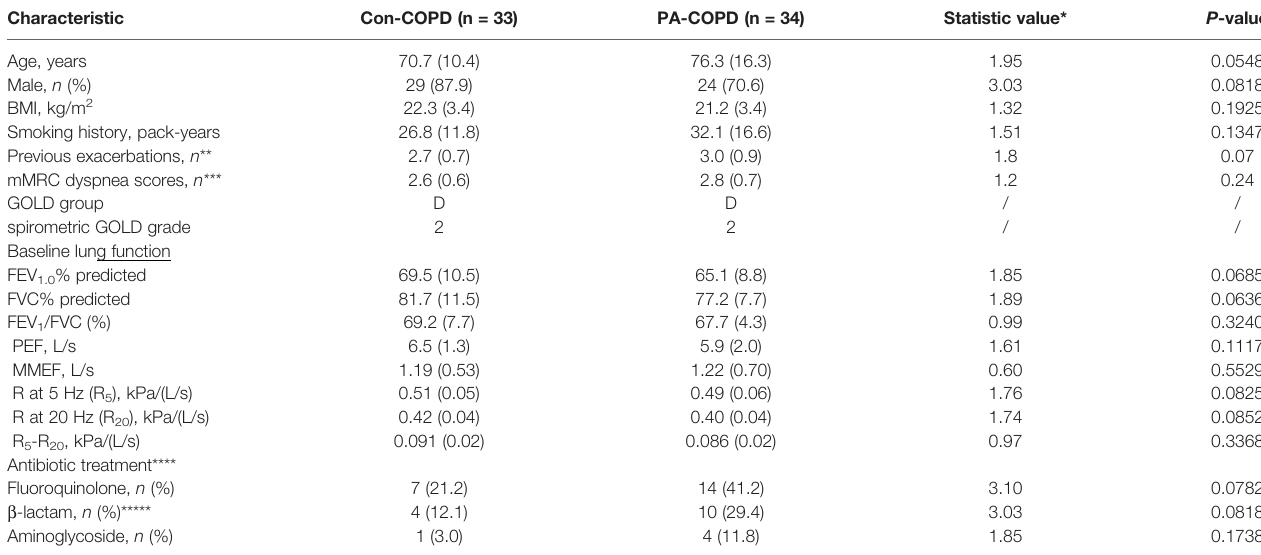
TABLE 1 | Baseline characteristics of COPD patients with or without P. aeruginosa infection. Characteristic